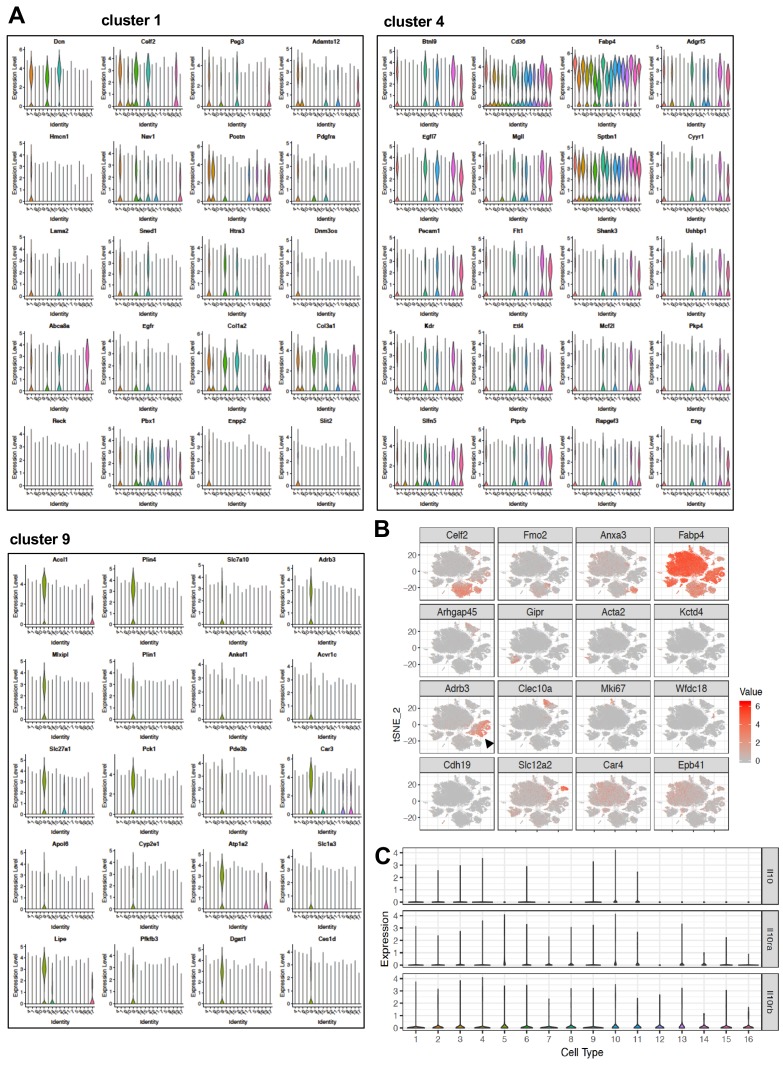
Type nine cluster constitute of thermogenic adipocytes.(A) Normalized expression values of top adipocyte subtype-specific major clusters (1, 4, and 9) genes from Figure 4A plotted as violin plots with clusters as rows and expression levels of genes as columns. (B) tSNE-plot showing cluster-specific expression of selected marker genes from aggregated tSNE-plot in Figure 4A. Black arrow indicates Type nine cluster. (C) Normalized expression values of indicated genes plotted as violin plots with clusters as rows and expression levels of genes as columns.